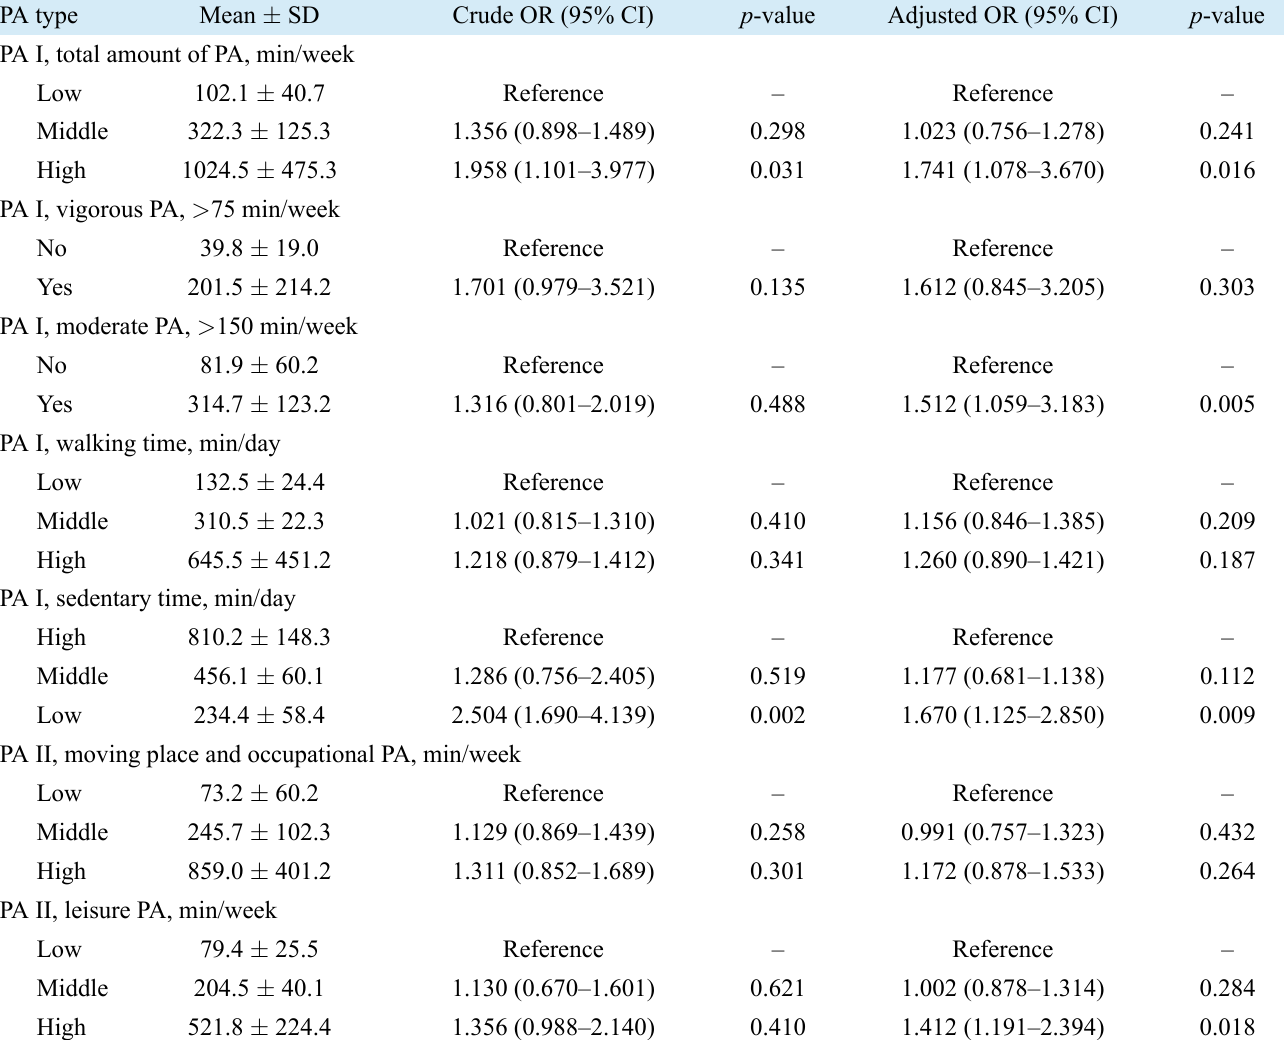
TABLE 4. Odds ratio of MHO for physical activity and sedentary time in